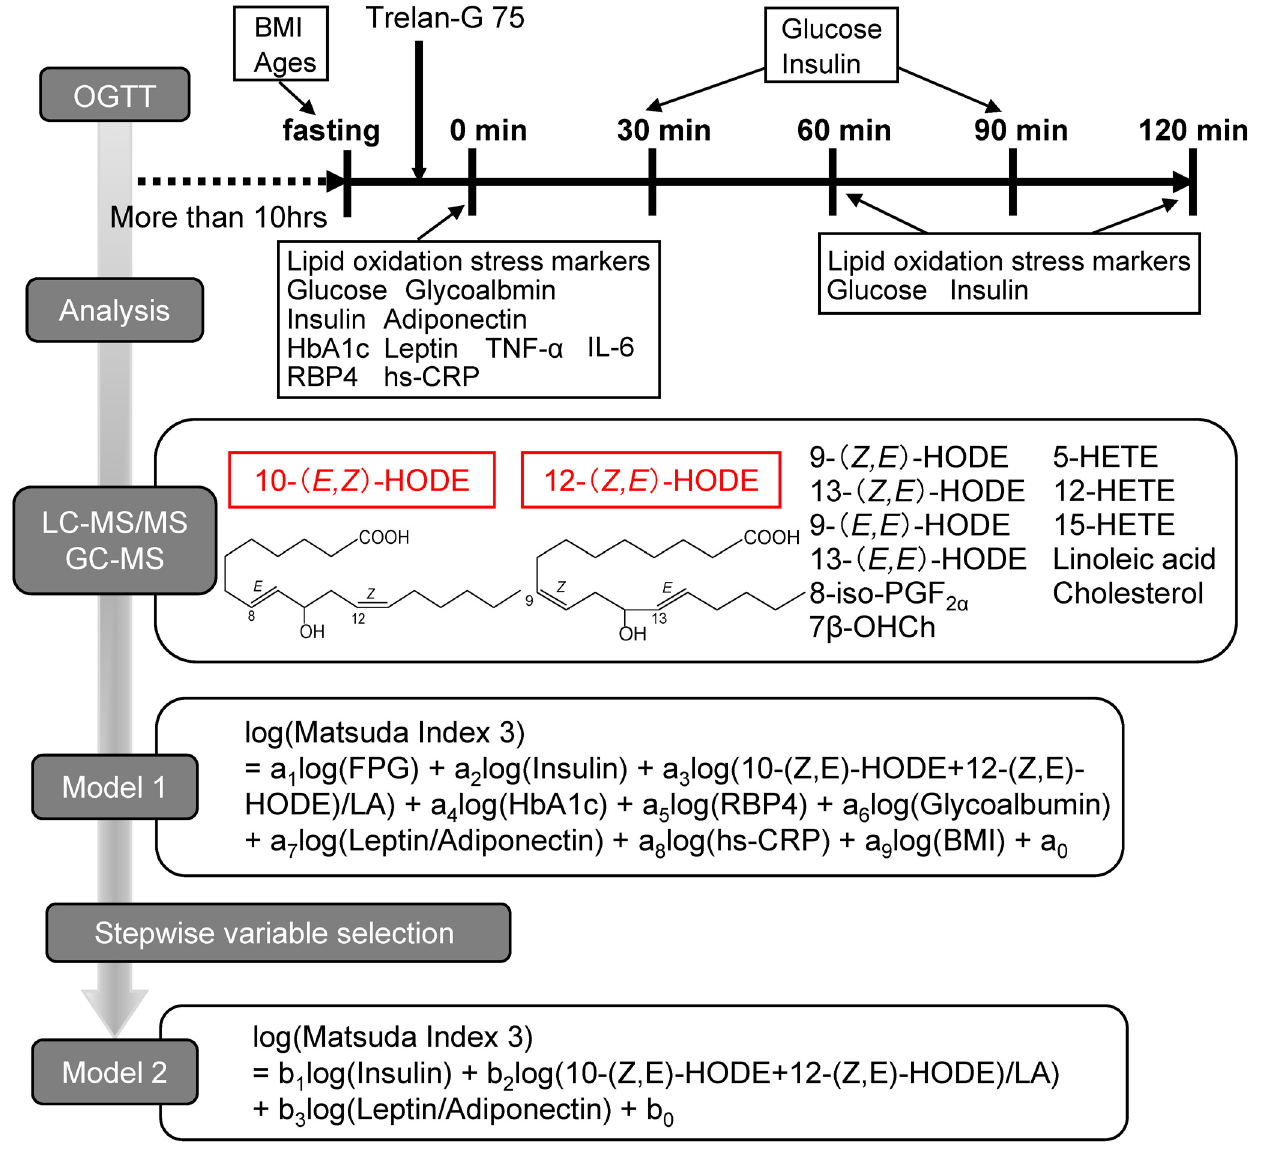
Fig 1. The study design, oral glucose tolerance test, and statistical analysis